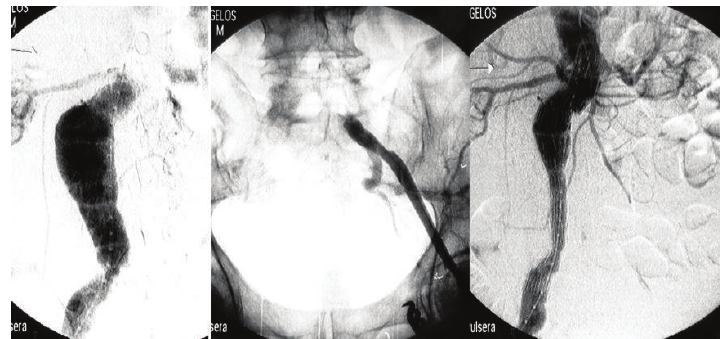
Figure 5: Concurrent AAA and left common iliac artery occlusion; an aortouniliac stent-graft insertion and a femoral-femoral bypass were performed.